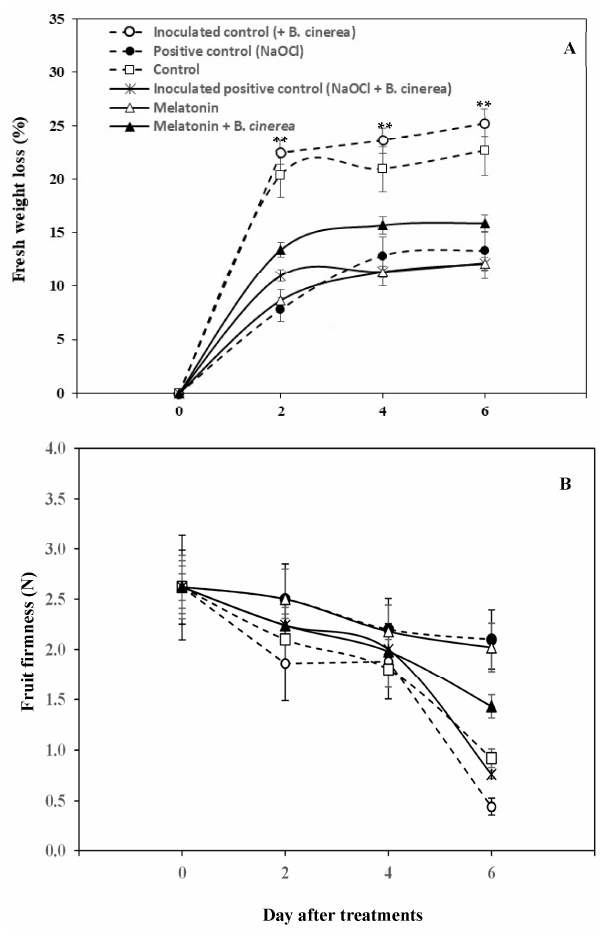
Figure 4. Fresh weight loss ( A ) and fruit firmness ( B ) of the strawberries treated with exogenous melatonin and inoculated with and without Botrytis cinerea during storage at room temperature (25 ± 2 ◦ C, 80–85% RH) for 6 days. Data are the means ± S.D. of three replications (three sets of ten fruits). Significant differences between treatments are indicated with asterisks (** ( p <